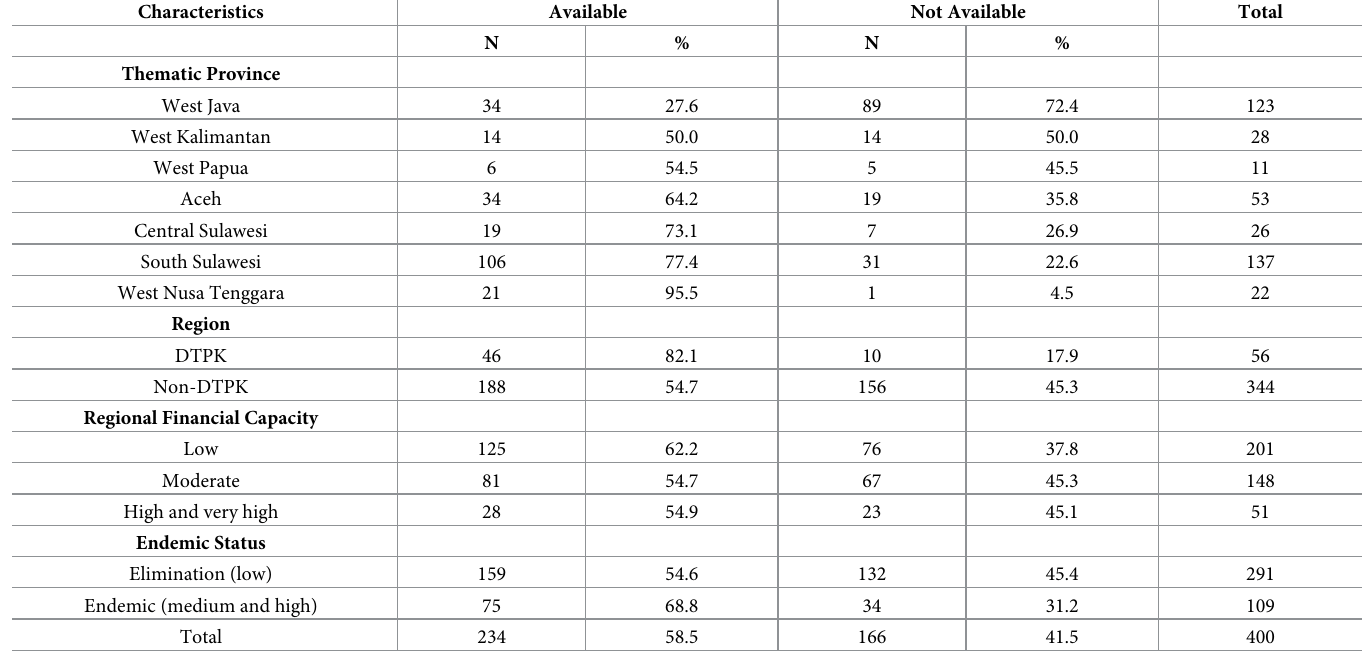
Table 1. Availability of malaria surveillance information systems at primary health centers (n = 400).